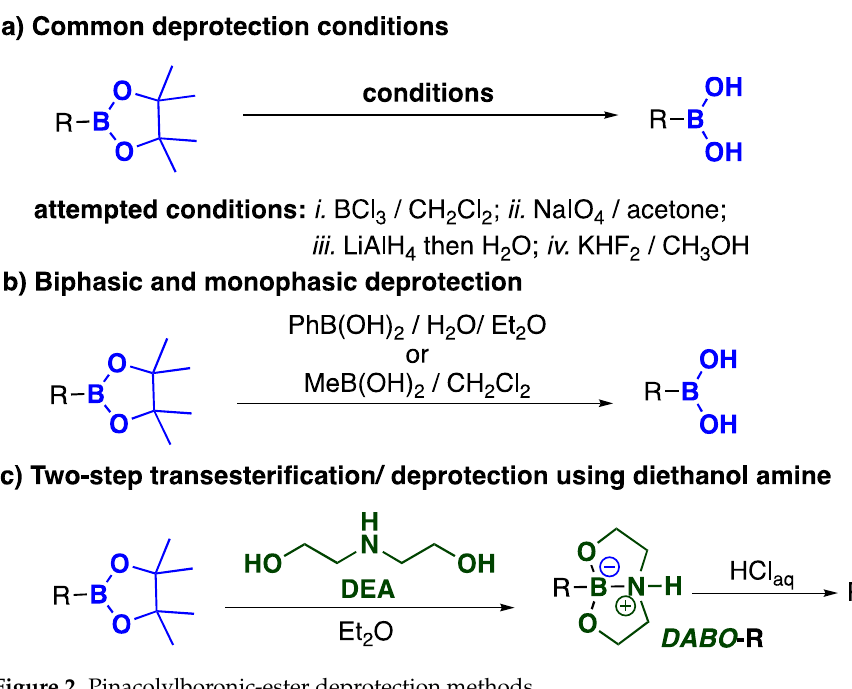
Figure 2. Pinacolylboronic-ester deprotection methods.